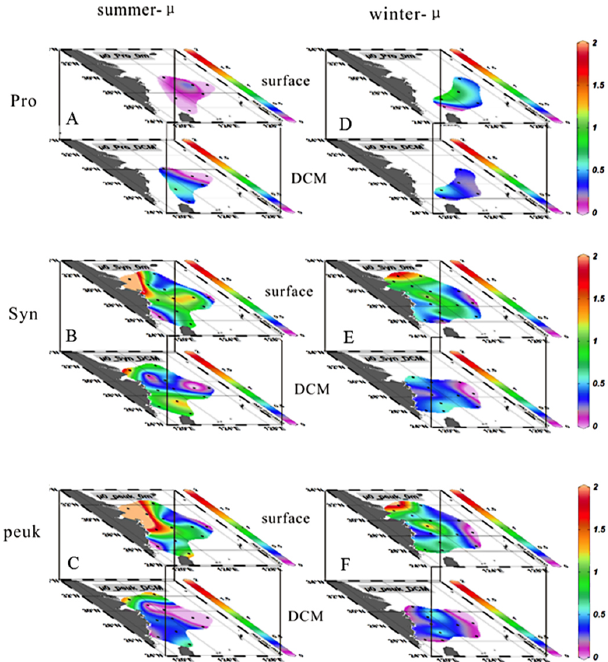
Fig. 6b. Spatial pattern of the grazing mortality ( m ) of the three picophytoplankton populations in (A–C) summer and (D–F) winter. The two layers are surface and deep chlorophyll maximum (DCM)